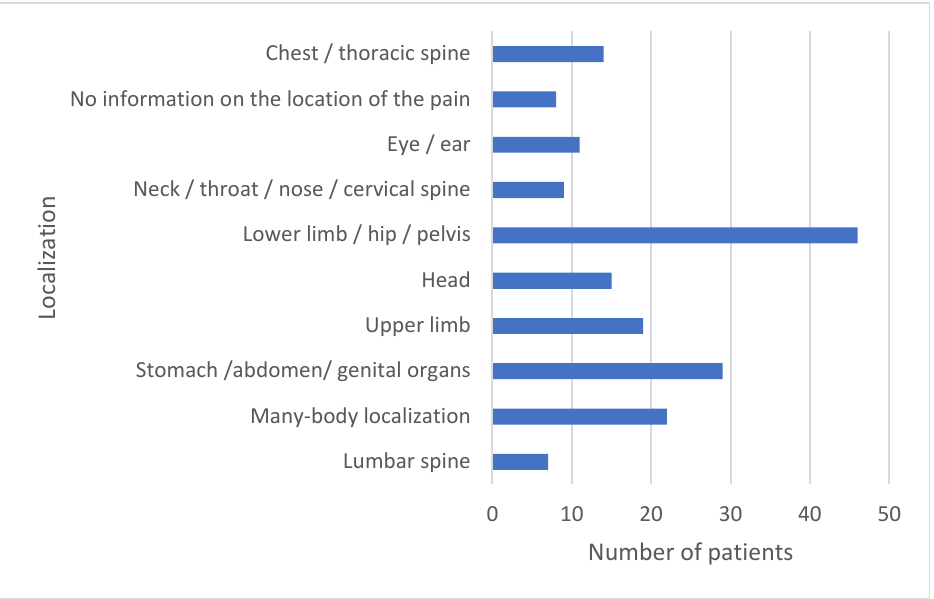
Figure 1. Localization of pain in people reporting to the hospital emergency department.